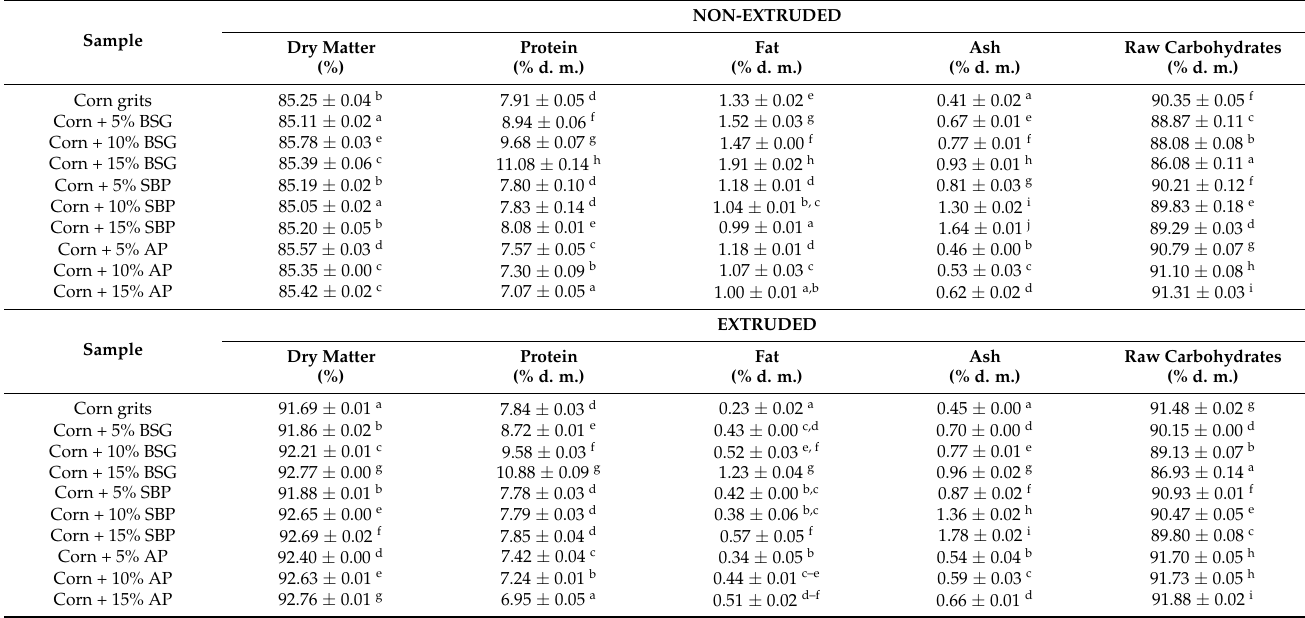
Table 1. Chemical composition of non-extruded and extruded